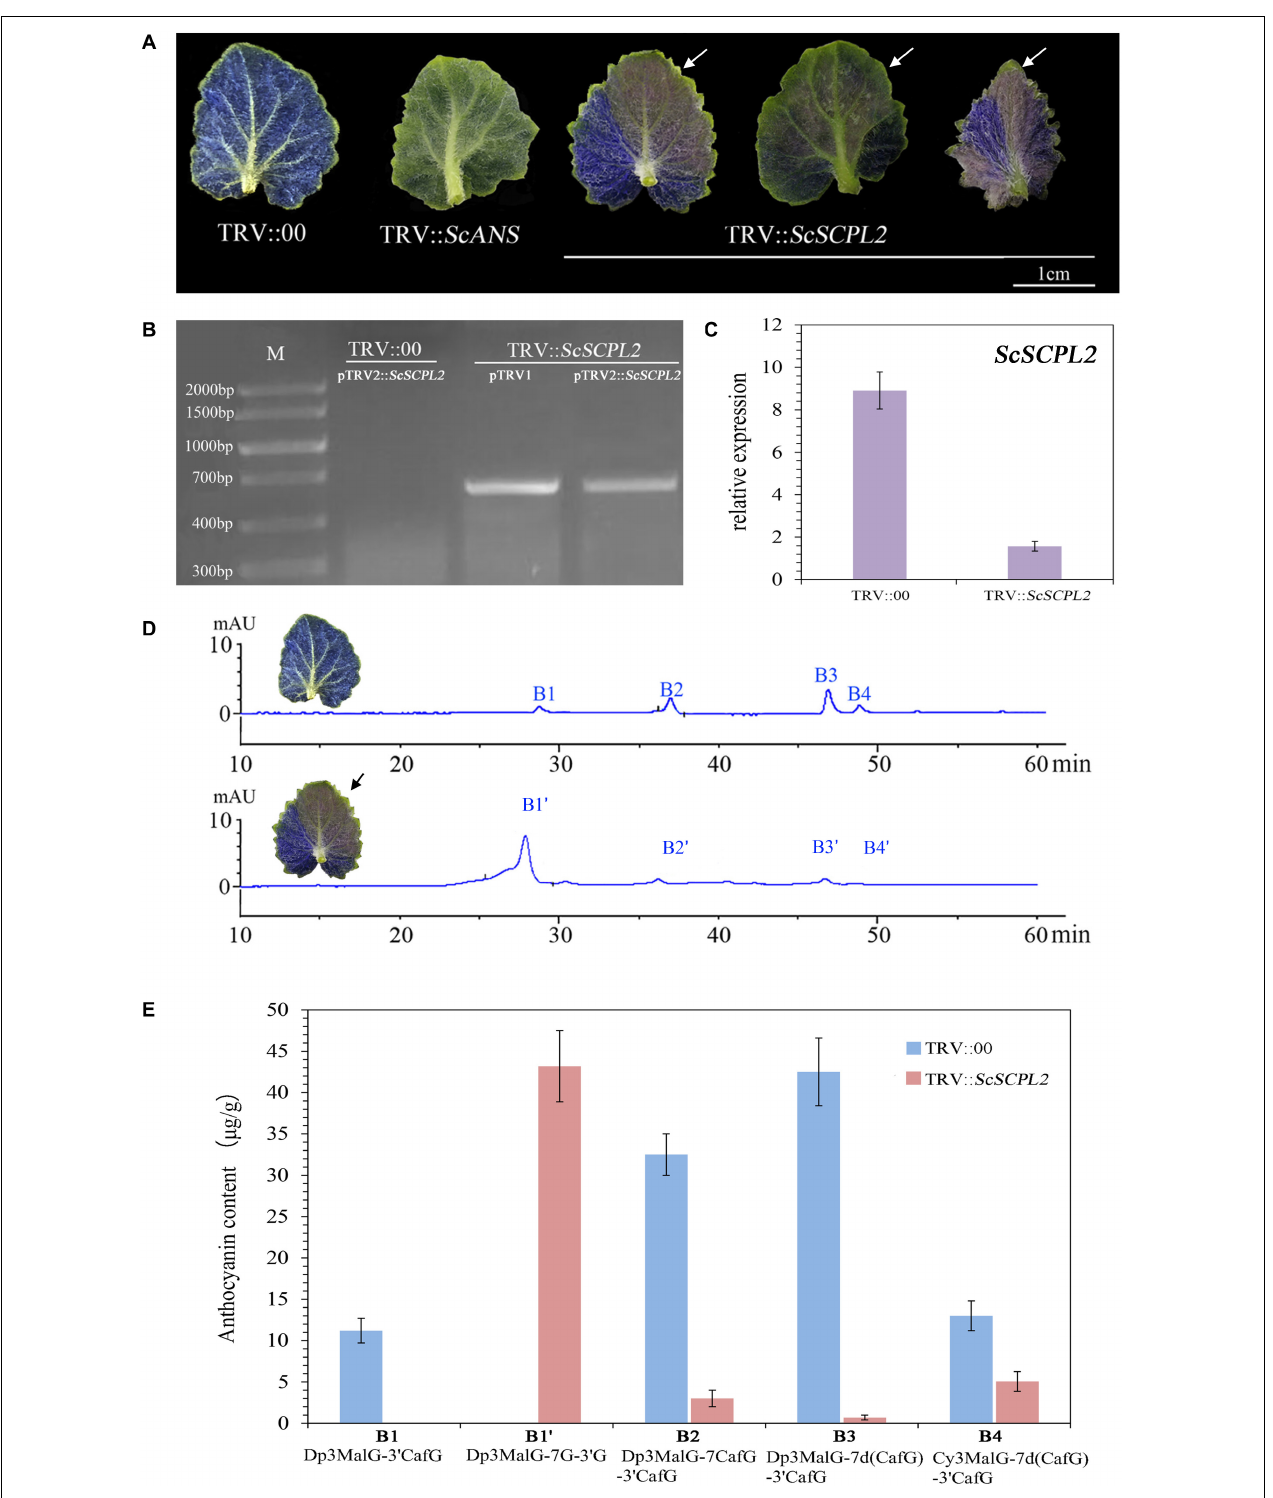
FIGURE 8 | Transient silencing of ScSCPL2 by VIGS in blue cineraria. (A) The phenotype of the leaves of blue cineraria whose ScSCPL2 gene was silenced by VIGS. (B) Detection of pTRV1 and pTRV2:: ScSCPL2 in the silencing tissue of blue cineraria. (C) qRT-PCR analysis of ScSCPL2 both in the silencing tissue and negative control. (D) Anthocyanin composition in the leaves and ScSCPL2 -silenced tissues of blue cineraria by HPLC analysis. (E) The content of anthocyanins in the leaves and ScSCPL2 -silenced tissues of blue cineraria.